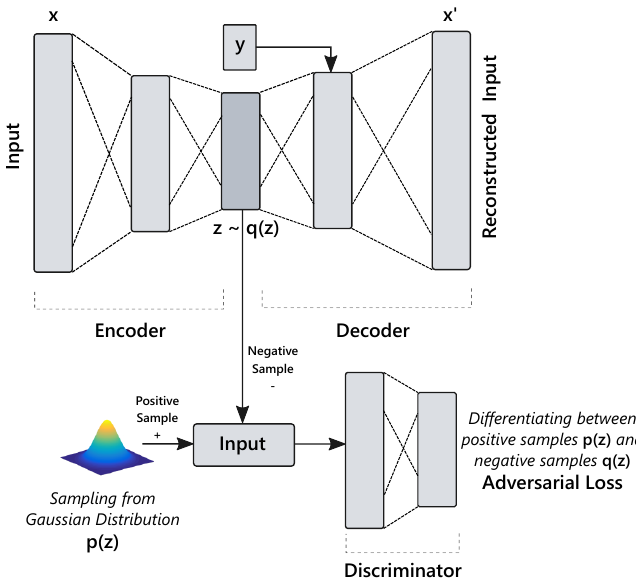
Figure 3. An Adversarial autoencoder network